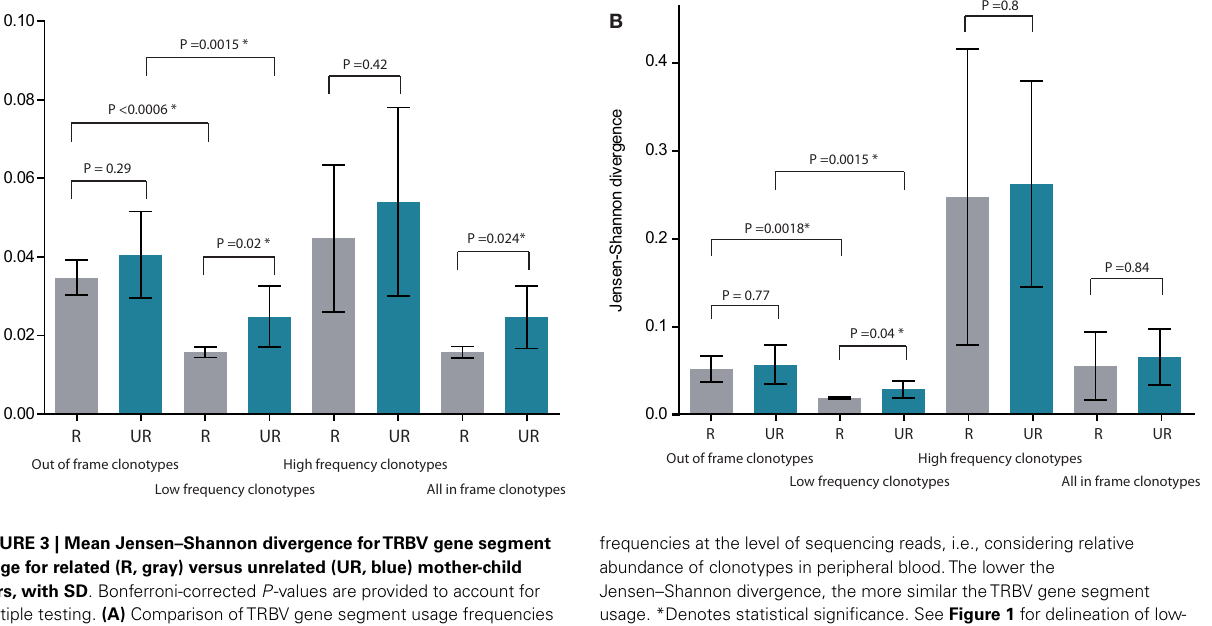
FIGURE 3 | Mean Jensen–Shannon divergence forTRBV gene segment usage for related (R, gray) versus unrelated (UR, blue) mother-child pairs, with SD . Bonferroni-corrected P -values are provided to account for multiple testing. (A) Comparison ofTRBV gene segment usage frequencies at the level of distinctTCR beta clonotypes (but not sequencing reads, so that the influence of relativeTCR beta clonotype size within a given repertoire is excluded). (B) Comparison ofTRBV gene segment usage